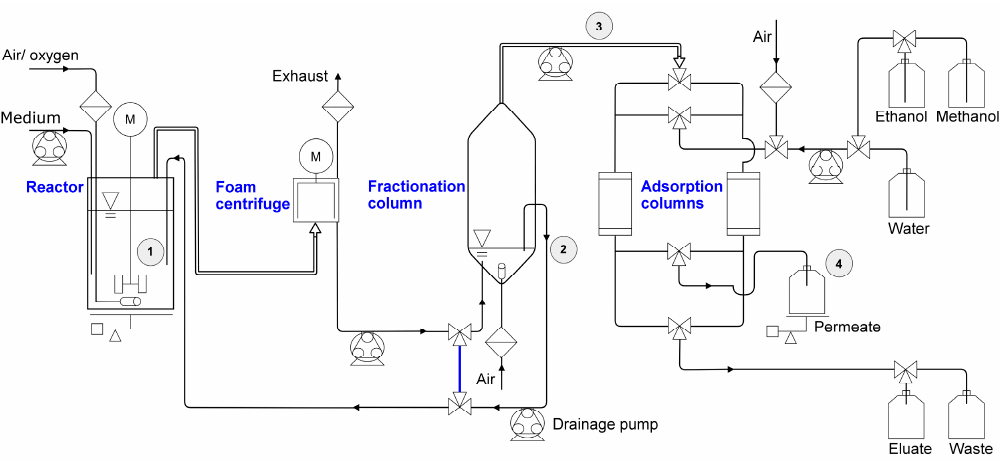
Figure 2. Fermentation setup with the two stages in the growth phase, and the harvest phase. Growth phase: 1st stage: no gassing into the stirred bioreactor. 2nd stage: activated gassing; discharging foam through the exhaust into the foam centrifuge; foamate reflux into the reactor (bypass in blue). Harvest phase: introduced by stopping the reflux and guiding the foamate into the fractionation column, equipped with an aeration and a separation of drained liquid back into the bioreactor. Fractionated foam left the upper opening of the fractionation column into the automated adsorption unit with two alternating adsorption columns. Permeate was collected and weighed, the eluate was collected separately. Bioreactor working volume was maintained by weight-controlled refill. Sampling points are marked as ① reactor, ② drainage reflux, ③ fractionated foam, ④ permeate inlet.